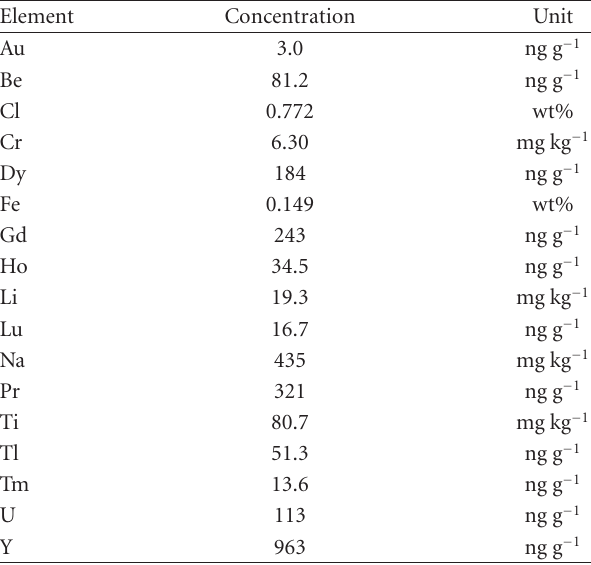
Table 3: Certified values for INCT-OBTL-5 ( X ± U ). Table 4: Information values for